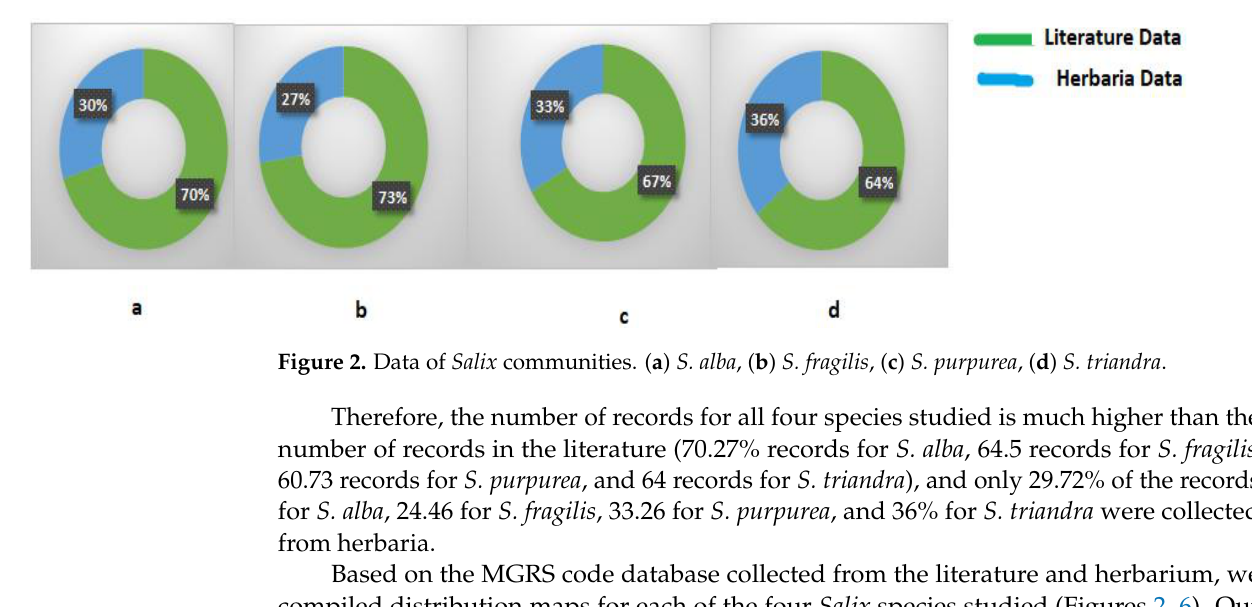
Figure 2. Data of Salix communities. ( a ) S. alba , ( b ) S. fragilis , ( c ) S. purpurea , ( d ) S. triandra